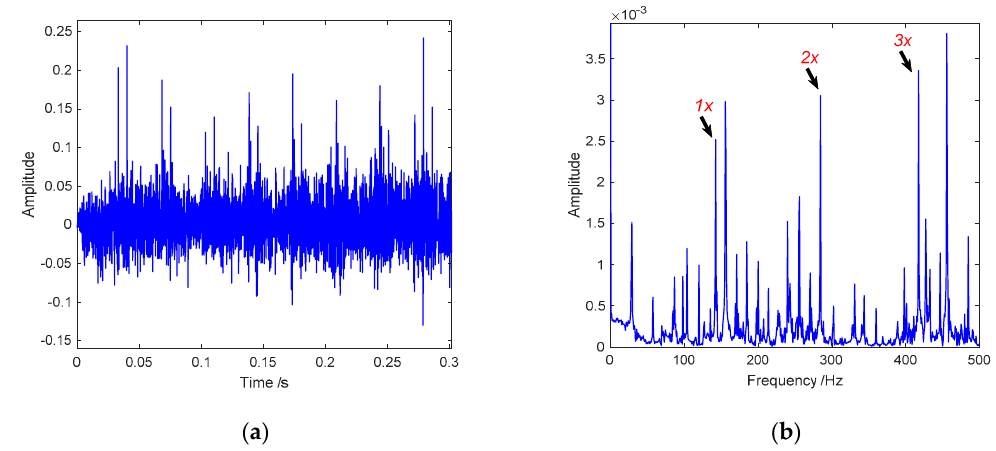
Figure 17. Results based on MCKD in case 2: ( a ) In the deconvolution signal, impulses are revealed; ( b ) the frequency spectrum also captures the characteristic fault, but it is interfered.